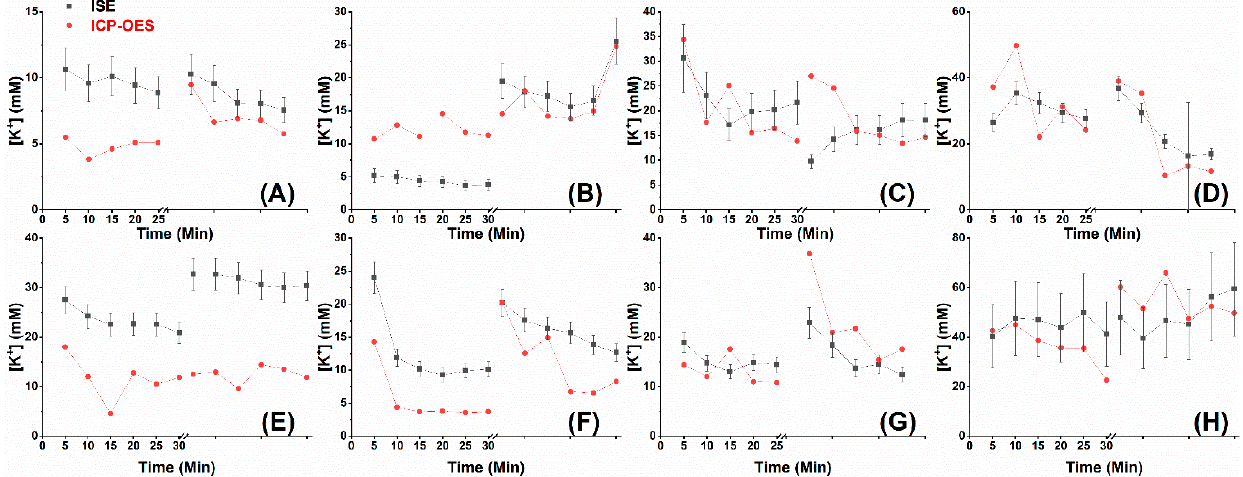
Figure 3. Time profile of the sweat potassium ions of eight volunteers ( A – H ). The data points on the left of the break on the X-axis are for the values collected for drinking purified water; while the data points on the right were collected for drinking a mineral drink. The time intervals between data points are the same in both sides of the break.